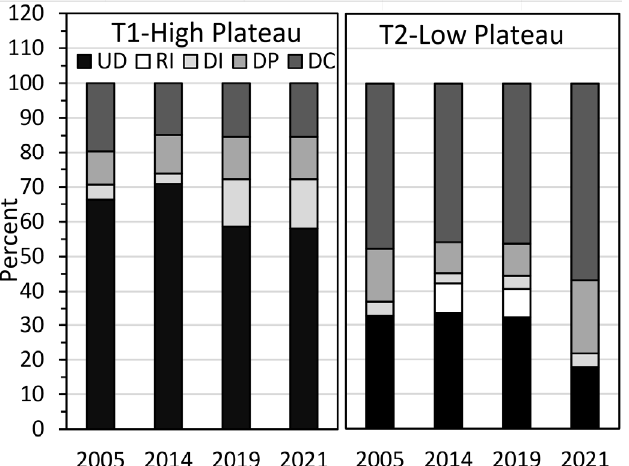
Figure 8. Frequency of the occurrence of five permafrost degradation stages along Transects 1 and 2 at Gosling Lake. Stages are undegraded (UD, including recovered old), degradation initial (DI, with increased thaw depths but lacking a talik), degradation progressive (DP, with shallow talik), degradation complete (DC, no frost at depth indicating deep talik or open talik), and recovery initial (RI, recent thin permafrost formation).